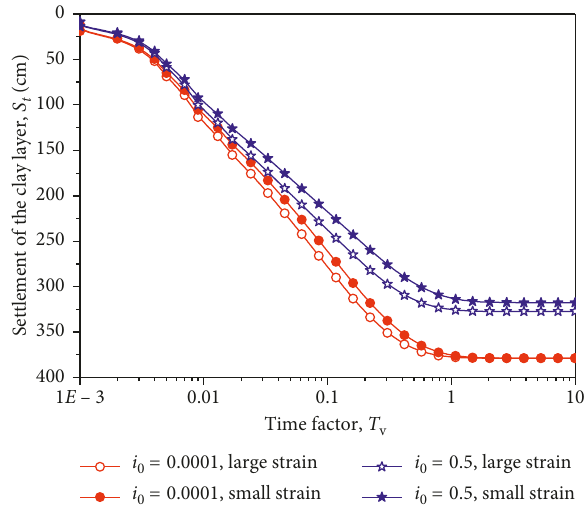
Figure 12: Influence of geometric supposition on S